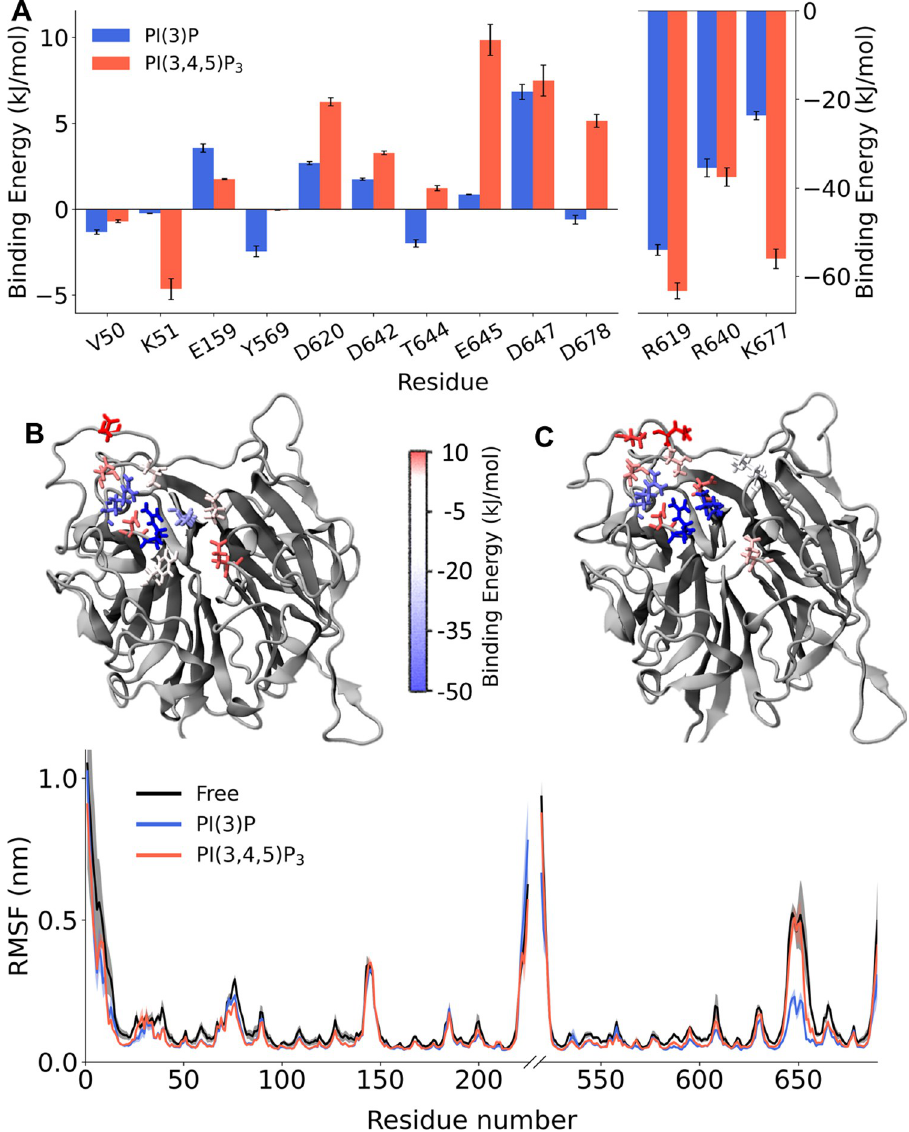
Fig 3. Comparison of RLD-PIPs interaction. ( A ) Decomposition of PI(3)P and PI(3,4,5)P 3 binding free energy, where error bars represent standard deviations. ( B ) Visual rendering of PI(3)P binding energy decomposition. ( C ) Visual rendering of PI(3,4,5)P 3 binding energy decomposition. ( D ) Comparison of RMSF values in absence and presence of PIPs. The shaded areas represent the standard deviation of the RMSF between the simulations. Loop L1, L2, and L3 are highlighted within the RMSF